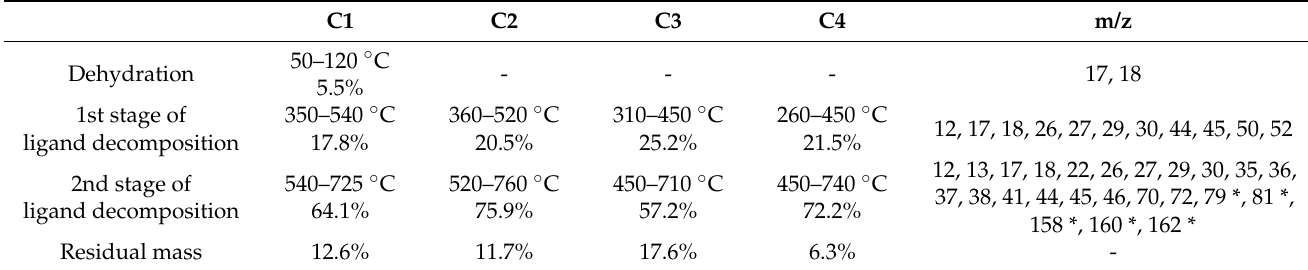
Figure 5. Thermal analyses of zinc (II) coordination compounds. TG (green), DTA (blue) and DTG (red) curves for complexes C1 – C4 . Table 4. Temperature ranges and mass losses of thermal decomposition stages of cadmium (II) coordination compounds.